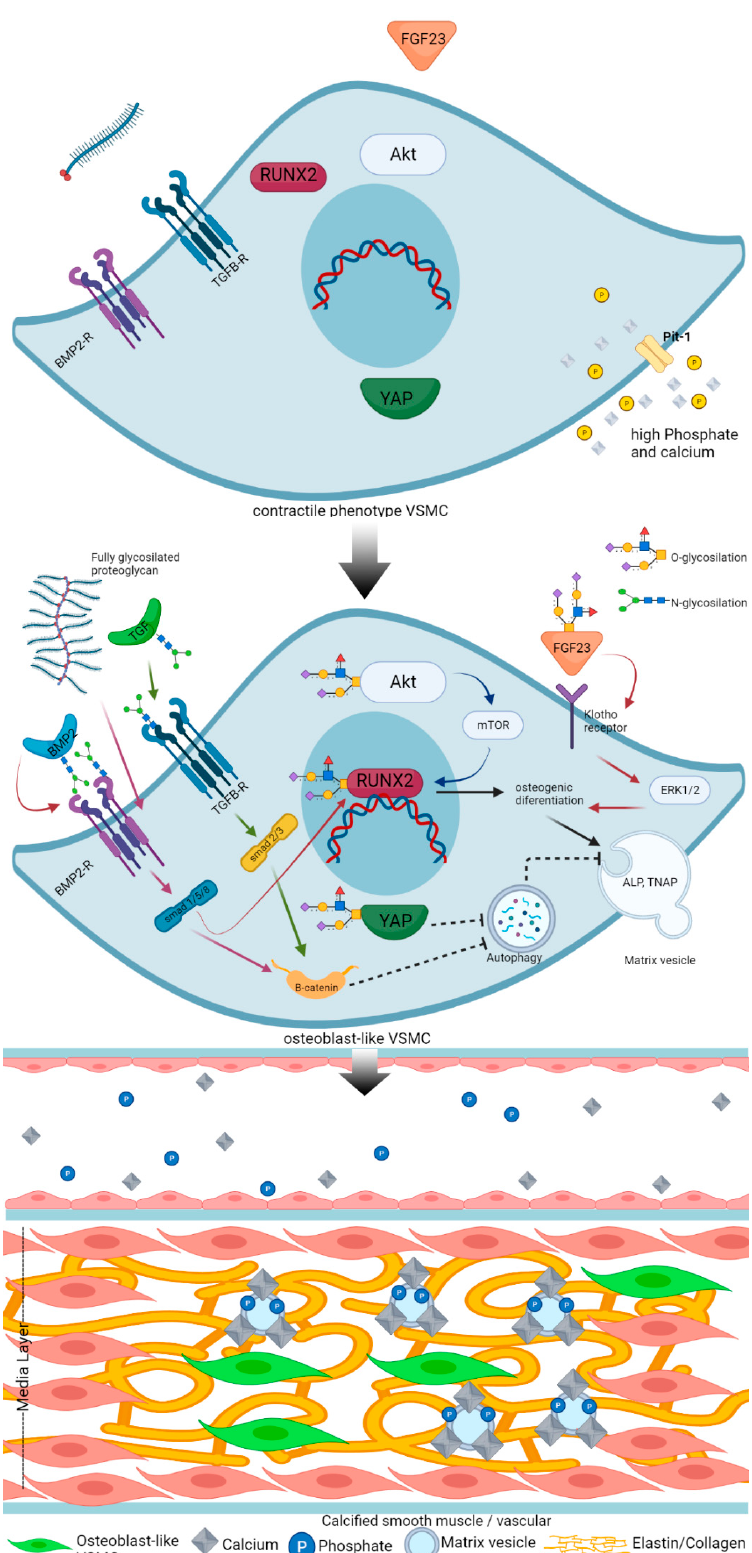
Figure 1. Proposed mechanism of how glycosylation of regulatory factors affects vascular calcification. Mechanism of vascular calcification involves loss of inhibitor and gain inducer. In the condition rich of phosphate and calcium, the VSMC transdifferentiates into osteoblast-like cell ( top panel).